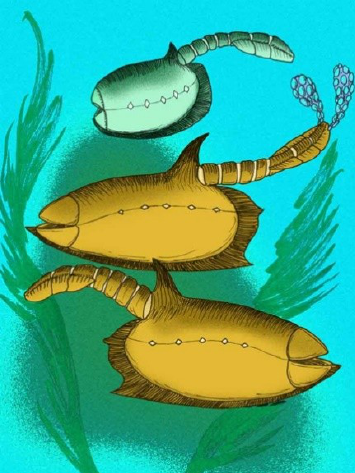
Figure 12. Vetulicola rectangulata (top specimen) and Vetulicola cuneata (center and bottom specimens). Note, the wedge beak in Vetulicola cuneata . PaleoArt credit: Apokryltaros. Used here per CC BY-SA 3.0.